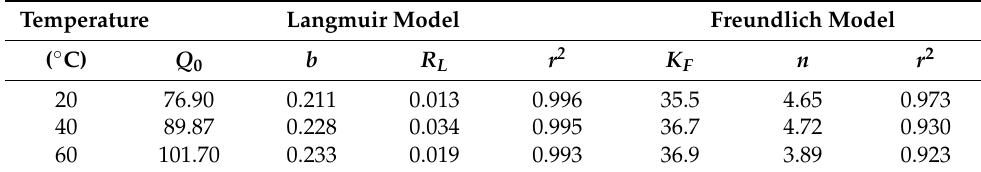
Table 2. Calculated equilibrium constants for the adsorption of MB onto functionalized CNF. Temperature Langmuir Model Freundlich